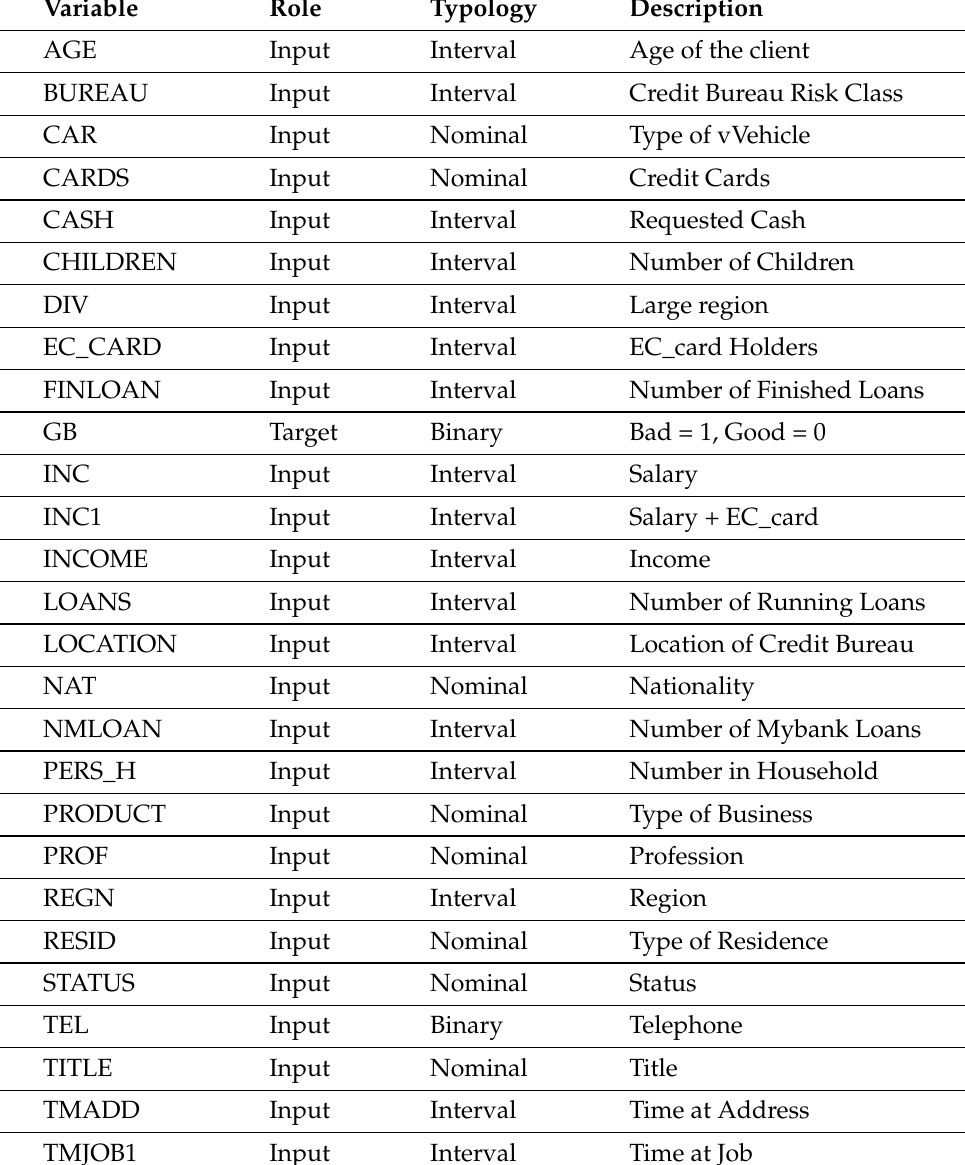
Table A1. CS_ACCEPTS